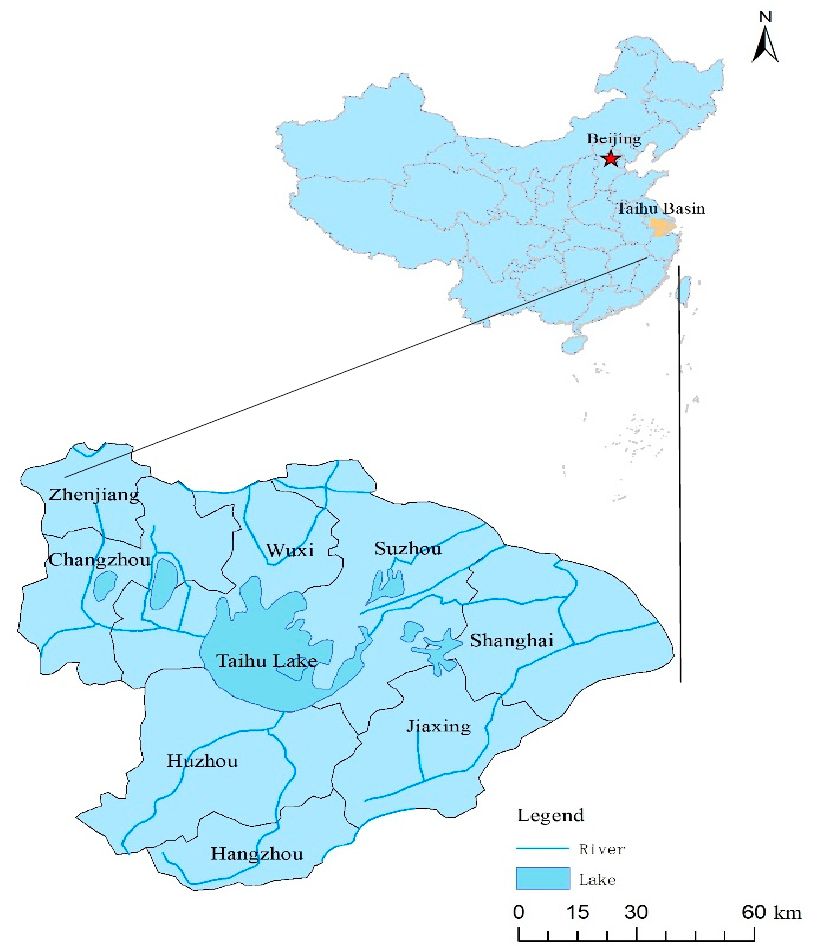
Figure 1. Administrative regions in Taihu Basin.